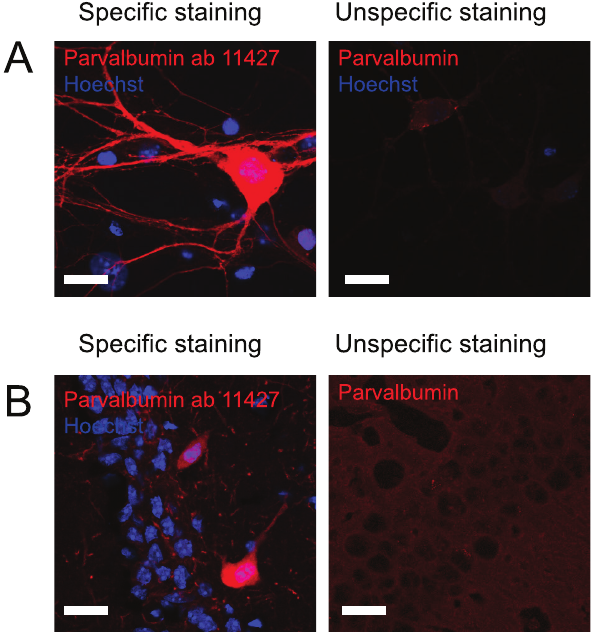
Figure 2. Staining against calretinin. Figure 2 shows immunostaining against calretinin on A ) cultured hippocampal neurons and B ) hippocampal tissue. Left pictures shows an example of an immunostaining considered to be specific while right picture